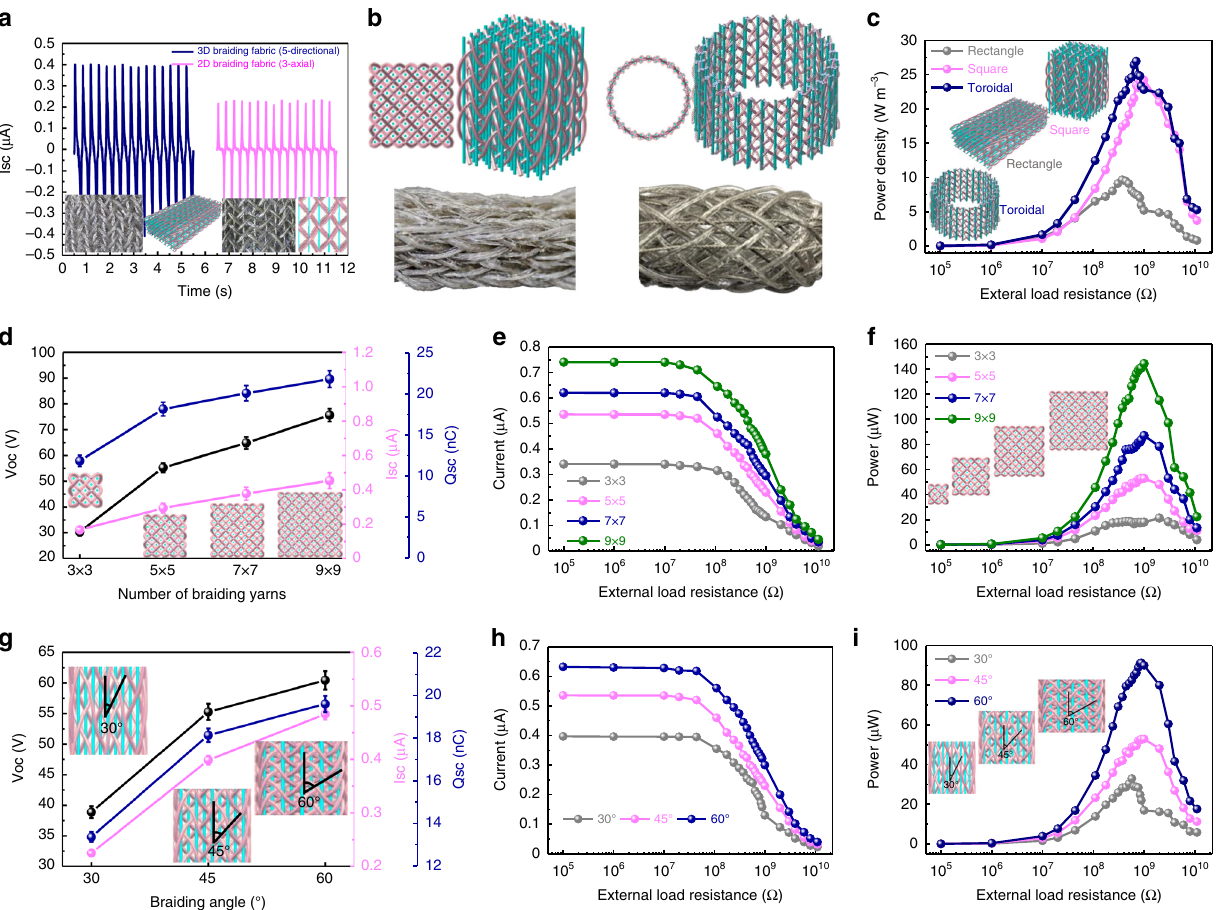
Fig. 3 Effect of braiding parameters on the electrical output performance of the 3DB-TENG. a Comparison of the I SC between the 3DB-TENG and a multilayered 2D triaxial braided TENG fabric. Their respective photographs and structural diagrams are displayed at the bottom. b Structural diagrams (top) and photograph images (bottom) of the 3DB-TENGs with square-shaped (left) and toroidal-shaped (right) cross sections. c Comparison of the power densities of the rectangle-shaped, square-shaped, and toroidal-shaped 3DB-TENGs. d Effect of the number of braided yarns (3 × 3, 5 × 5, 7 × 7 and 9 × 9) on the power output of the 3DB-TENGs. e , f Comparisons of the ( e ) current and ( f ) power of the square-shaped 3DB-TENGs with different number of braided yarns. g Effect of the surface braiding angles (30°, 45°, and 60°) on the electrical output of the 3DB-TENGs. h , i Comparisons of the ( h ) current and ( i ) power of the square-shaped 3DB-TENGs with different surface braiding angles. The error bar indicates the range within a standard deviation. Source data are provided as a Source data fi